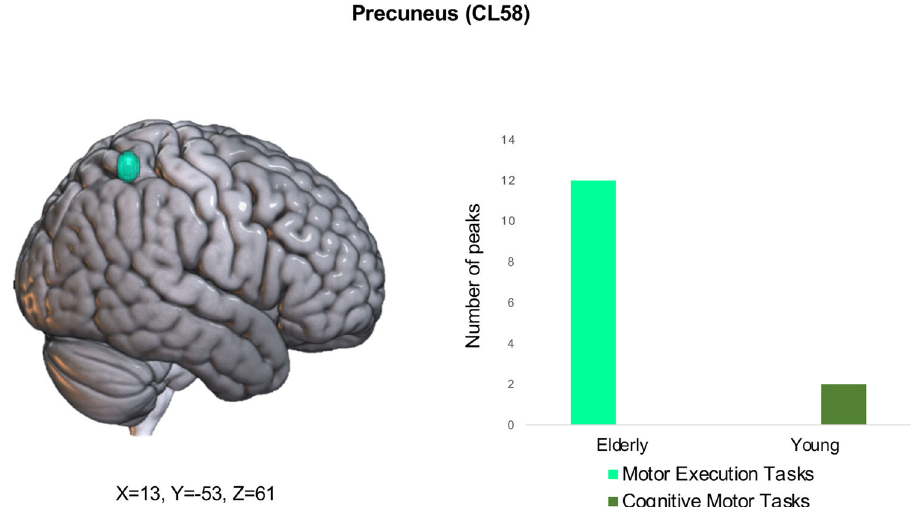
Fig. 3 Cluster showing a signi fi cant group-by-performance interaction effect. Light green bars indicate the number of peaks of the cluster associated with explicit motor execution tasks, dark green bars indicated the number of peaks associated with cognitive-motor tasks. Plots source data are provided in Supplementary Data